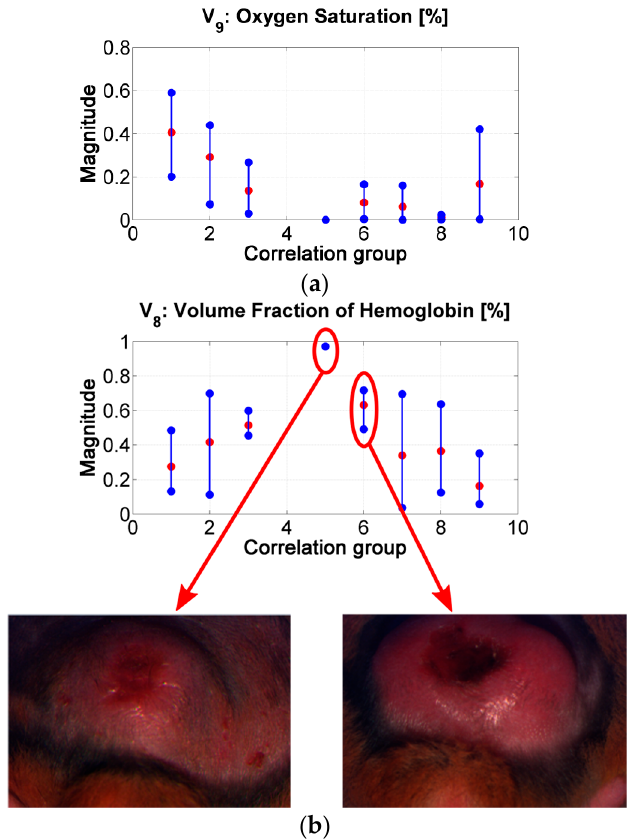
Figure 9. ( a ) results of the inverse-modeling procedure for variable V 9 : oxygen saturation. ( b ) results of the inverse-modeling procedure for variable V 8 : volume fraction of hemoglobin.